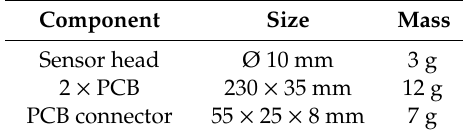
Table 1. Physical dimensions and masses of the sensor components.